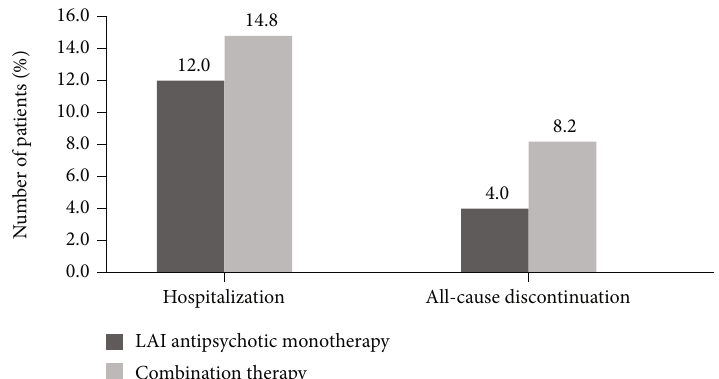
Figure 1: Hospitalization and all-cause discontinuation between the LAI antipsychotic monotherapy and combination therapy groups. Table 2: Hospitalization and all-cause discontinuation between LAI antipsychotic monotherapy and combination of LAI and oral antipsychotic groups.